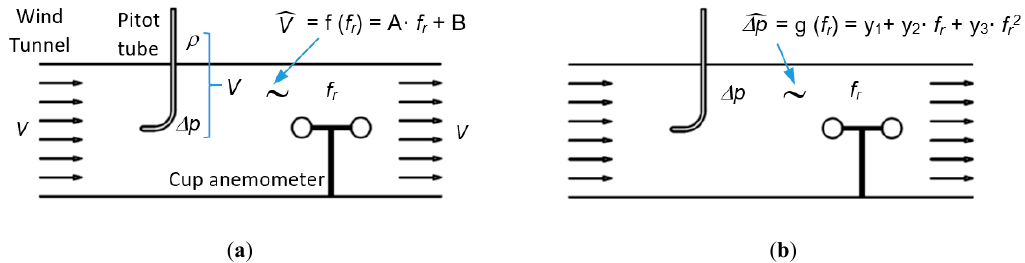
Figure 1. Calibration of a cup anemometer by means of a Pitot tube: ( a ) Conventional calibration: Air Speed Cup Anemometer (“AS-Cup Anemometer”), ( b ) Alternative calibration: Dynamic Pressure Cup Anemometer (“DYP-Cup Anemometer”).